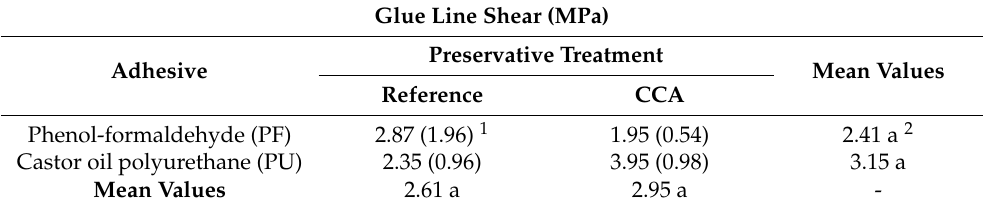
Table 7. Results: glue line shear.